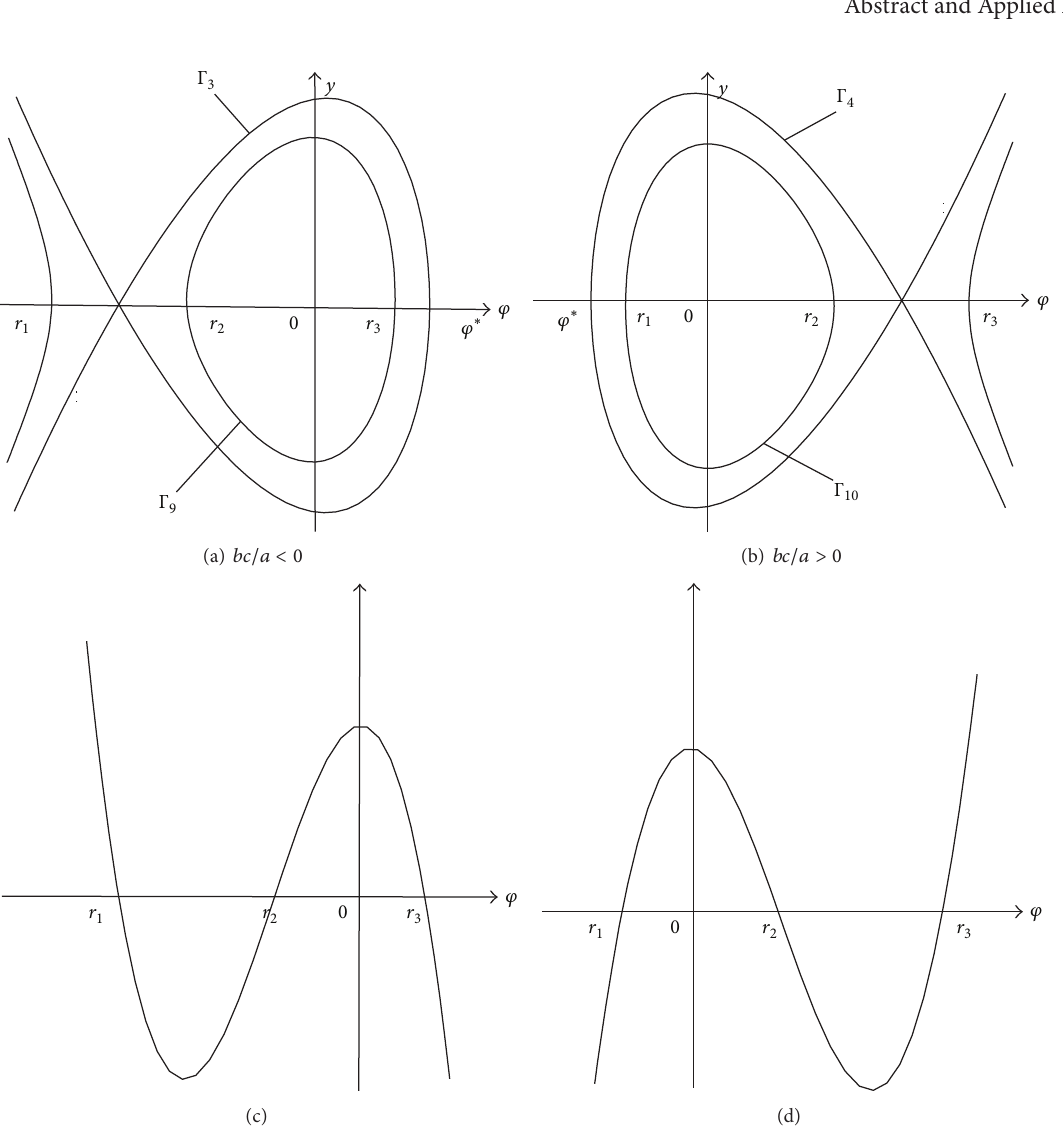
Figure 2: The bifurcation phase portraits of system (6) with 𝑔 = 0 and (1 + 𝑘𝑟 2 + 𝑐)/𝑏𝑐 > 0